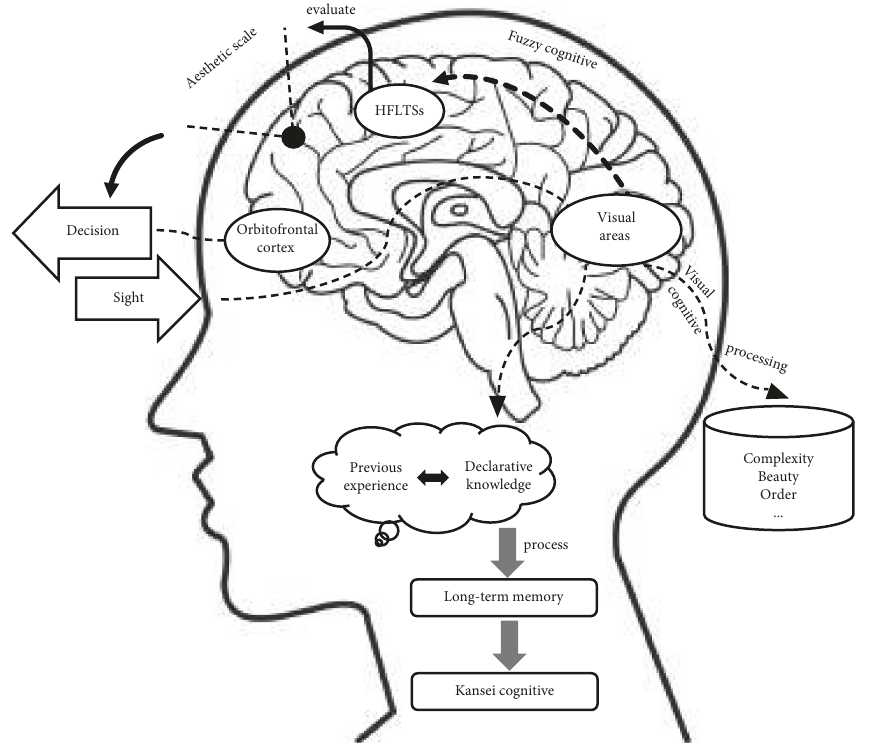
Figure 1: The decision-making process of the human brain after hesitant and fuzzy